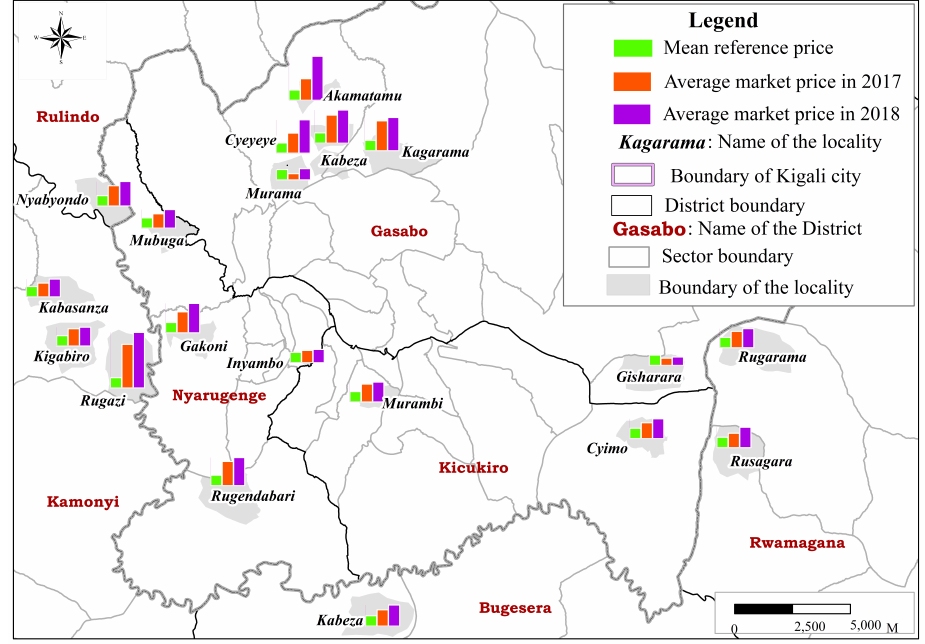
Figure 3. Figure4.This is a figure, Schemes follow the same formatting. If there are multiple panels, Figure 4. Comparison between mean reference price for expropriation and the market. Data sources: they should be listed as: ( a ) Description of what is contained in the first panel. ( b ) Description of what Household surveys; Land transaction reports and compensation reference prices list 2017–2018 [43]. is contained in the second panel. Figures should be placed in the main text near to the first time they are cited. A caption on a single line should be centered.